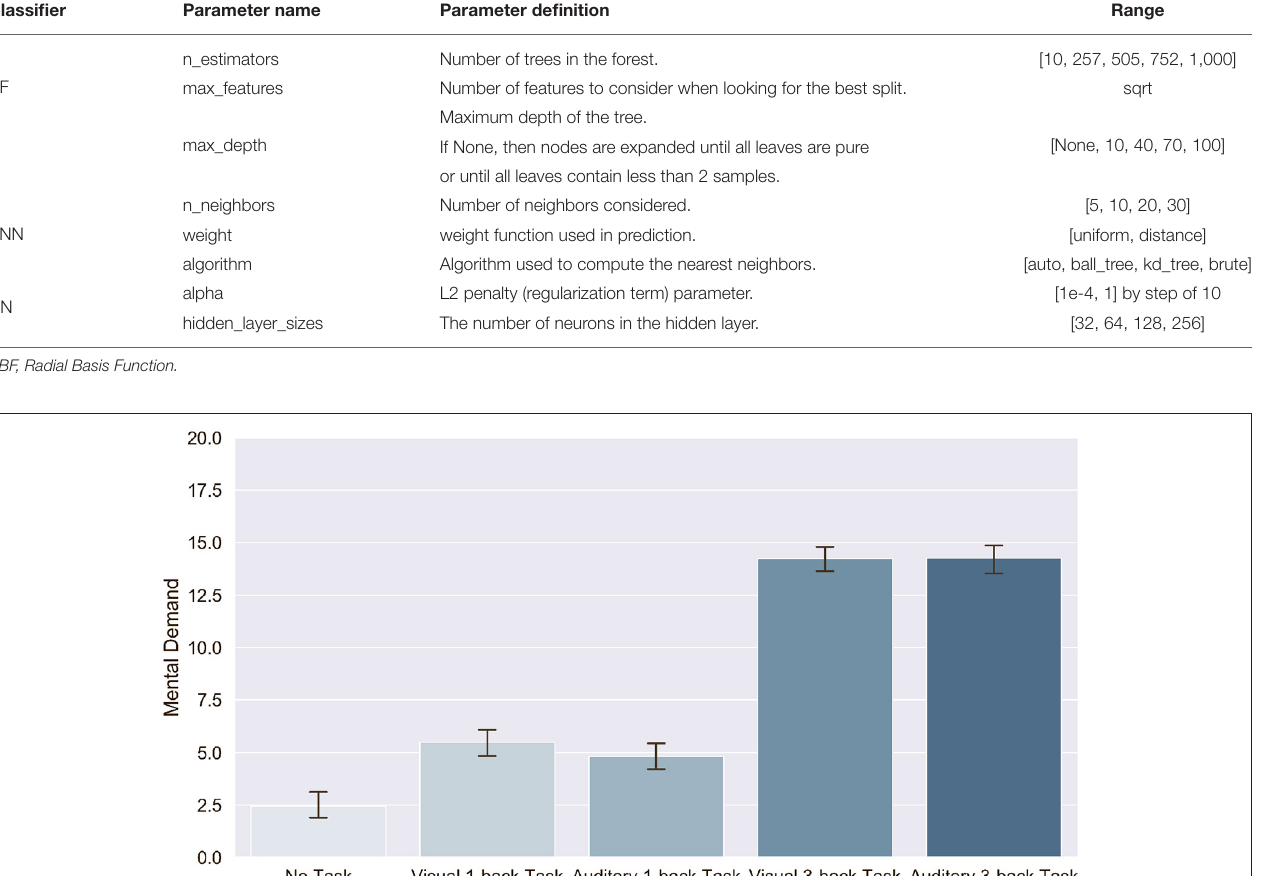
respiratory rate in the first epoch of each type of task ( M = 1.23, SE = 0.56) compared to the second one ( M = 0.32, SE =